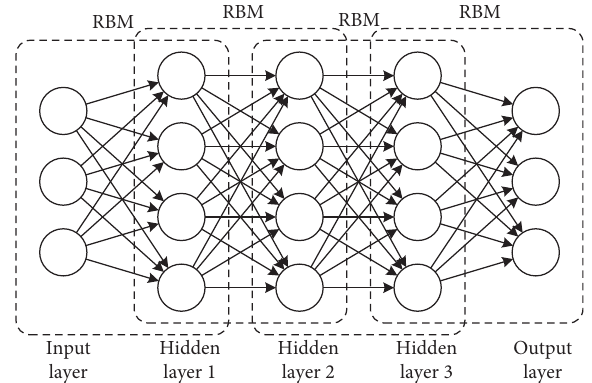
Figure 3: Deep belief networks.